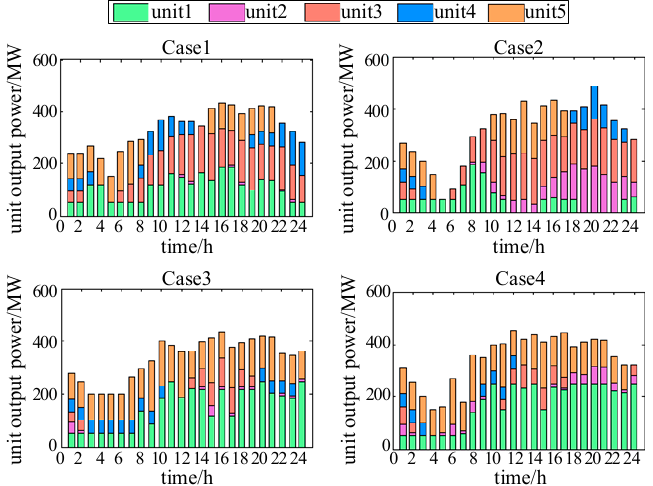
Figure 5. Output of each unit in Cases 1–4. In the figure, the green histograms represent the output of unit 1, which means the output of the first gas-fired unit. The purple histograms represent the output of unit 2, which means the output of the second gas-fired unit. The red histograms represent the output of unit 3, which means the output of the first coal-fired unit. The blue histograms represent the output of unit 4, which means the output of the second coal-fired unit. The orange histograms represent the output of unit 5, which means the output of the third coal-fired unit. Table 1. Costs of objective functions in Cases 1–4.